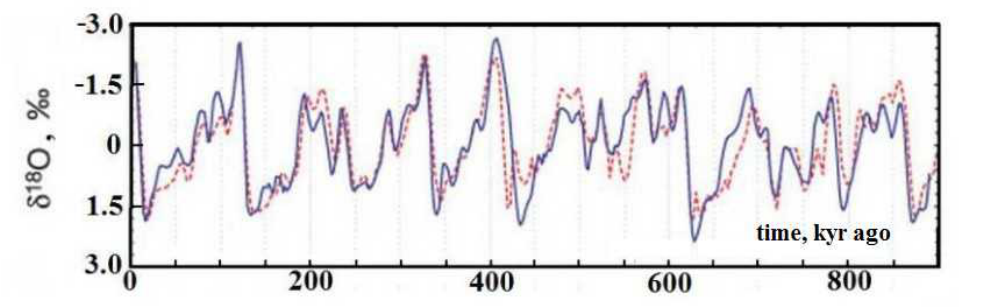
Figure 3. Relative change in the concentration of the oxygen isotope δ 18 O in carbon dioxide molecules located in bubbles according to measurements in ice deposits near the Dom C weather station (solid line) and the Vostok weather station (dots) in past near Antarctica